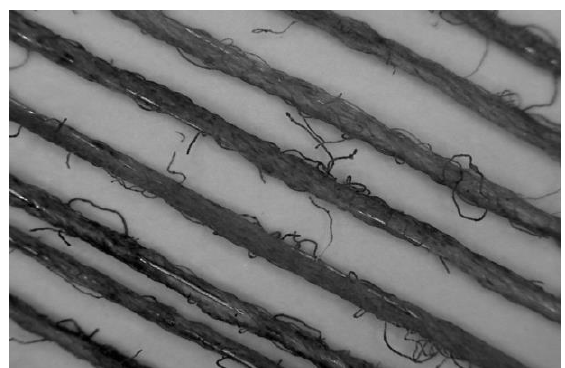
Figure 4. X35-times magnification coloured composite yarn.